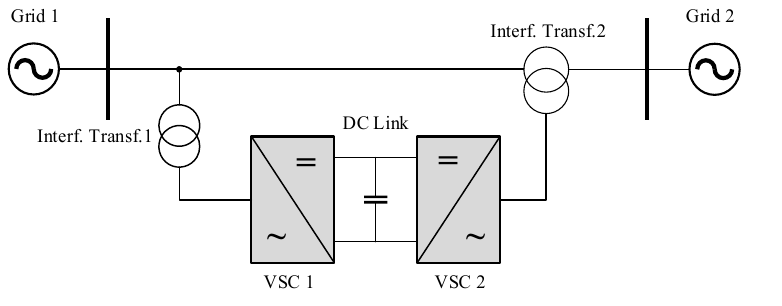
Figure 3. UPFC system topology.